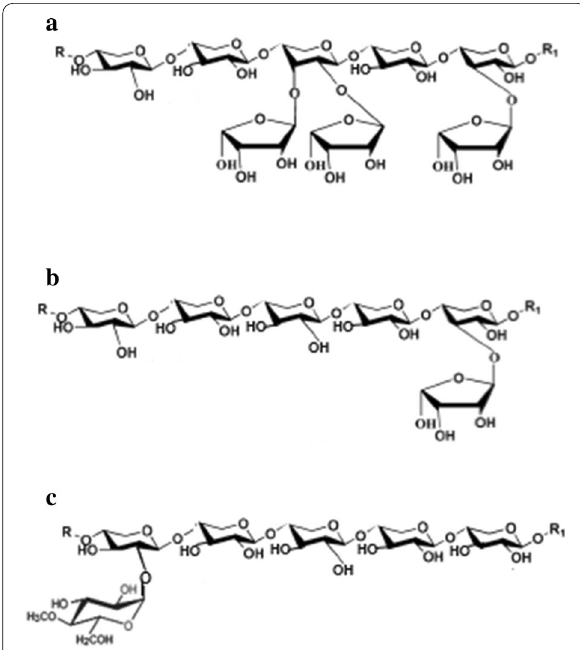
Fig. 2 The chemical structures of xylan from different sources. Xylan consists of the backbone chain of xylose units joined by β-1,4-glycosidic bond, and substituted by α-arabinofuranosyl residues at second or third carbon (C2-O- and/or C3-O-). The xylan backbone chain extension from the non-reducing end is represented by R and extension from reducing ends are represented by R1. The wheat arabinoxylan used in the current study was highly substituted as indicated in a and oat arabinoxylan had lesser substitution as indicated in b . Glucuronoxylan consists backbone of xylose units β-1,4- d -glycosidic bond that is substituted with 4- O -methyl-α- d -glu copyranosyl uronate residues. Beechwood xylan used in the current study consisted mostly of glucuronoxylan as indicated in